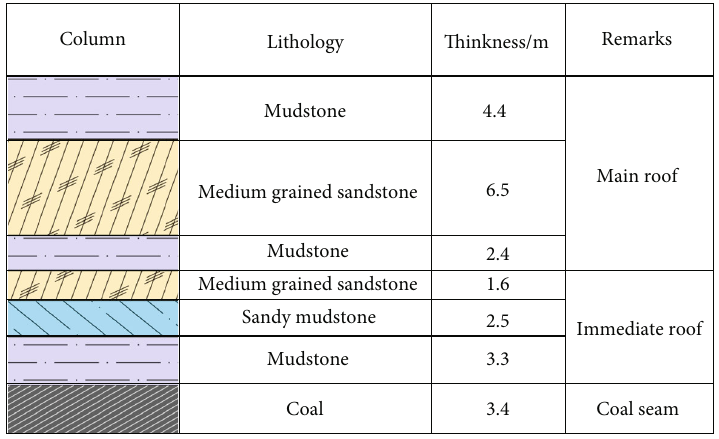
Figure 7: Prevailing geological